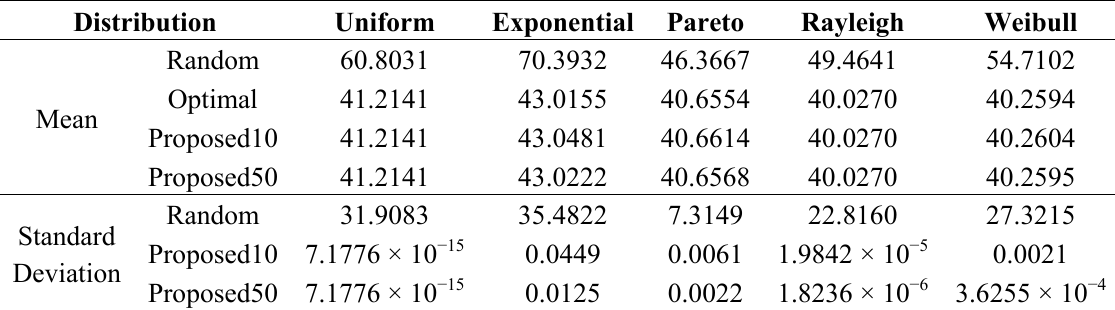
Table 4. Performance comparison (Case B). Note that “Proposed10” and “Proposed50” stands for “Proposed algorithm with 10 iterations” and “Proposed algorithm with 50 iterations”,